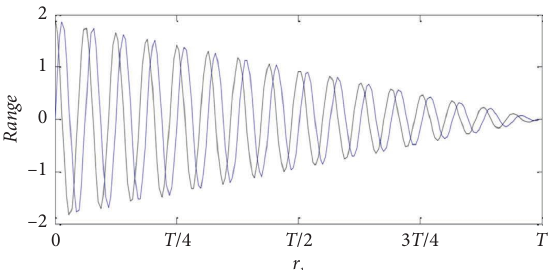
Figure 4: Model of descending the range of sine and cosine functions ( a � 3).